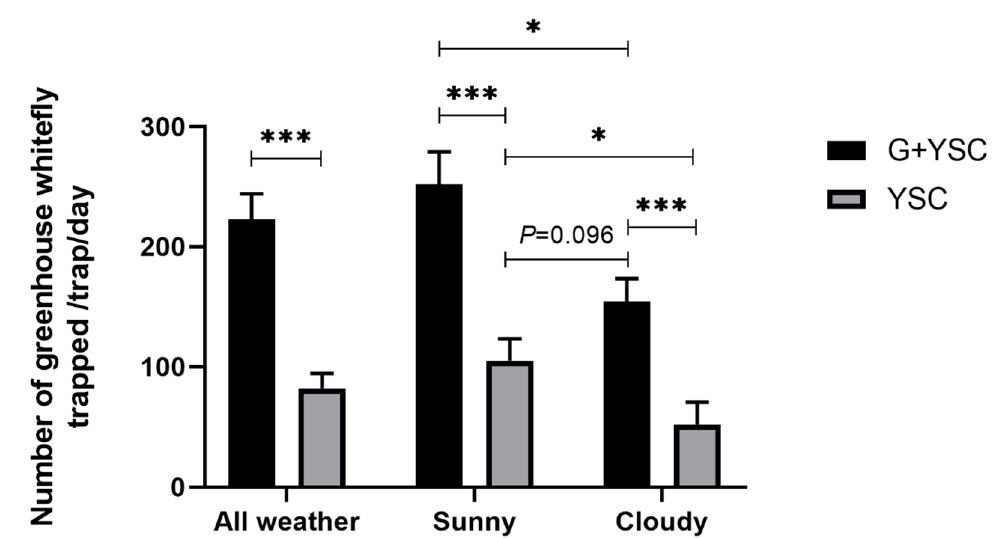
Figure 7. Effects of weather conditions on the trapping efficacy of the yellow sticky card or green LED-lit yellow sticky card trap. YSC, yellow sticky card; G, green LED light; *, significant difference at p < 0.05 by the independent t test; ***, significant difference at p < 0.001 by the independent t test. Error bars represent the standard error.